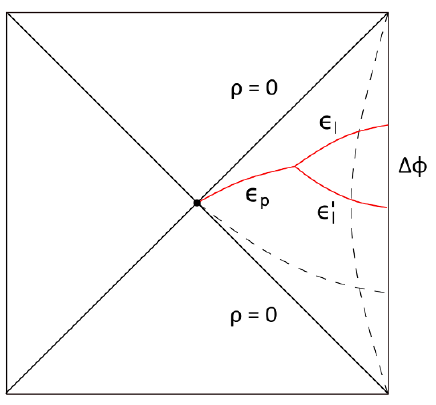
Figure 7 . The con(cid:12)guration of geodesics in the background of the BTZ black hole at the constant angle slice, which is dual to the semiclassical 4-point heavy-light conformal block on the sphere. The right triangle of this Penrose diagram is described by the metric (4.17) at t = const. The dashed lines are slices of surfaces (cid:30) = const and (cid:26) = const. The horizon is depicted by diagonal solid